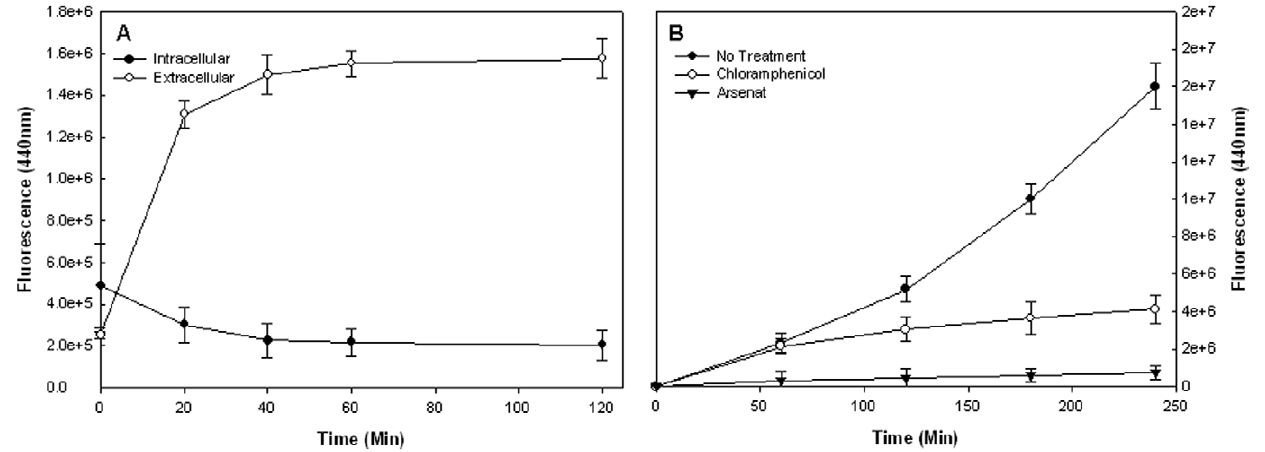
Figure 2. Effect of protein synthesis arrest on AGEs secretion. Bacteria were grown in MOPS minimal medium and samples were collected for AGEs determination as described in materials and methods. AGEs-specific fluorescence (Ex. 370, Em. 440) was determined and normalized to cells density. A) Intracellular and extracellular AGEs levels following exposure to chloramphenicol. B) Effect of chloramphenicol (open circles) and Arsenate (triangles) on AGEs secretion kinetics. The data represent three independent experiments.